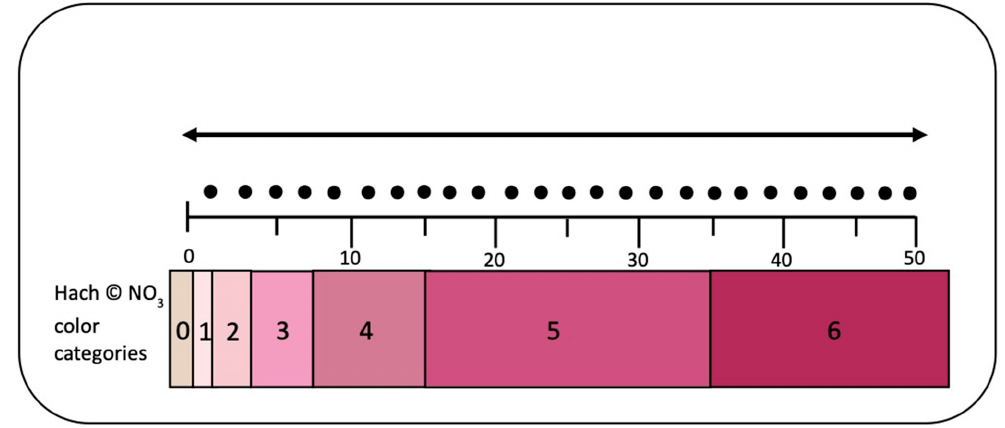
Figure 3 The dots represent continuous sample concentrations and their designated Hach© category bins. For example, concentrations that fall between 15.1 and 35.9 ppm (or mg/L) would be binned into category